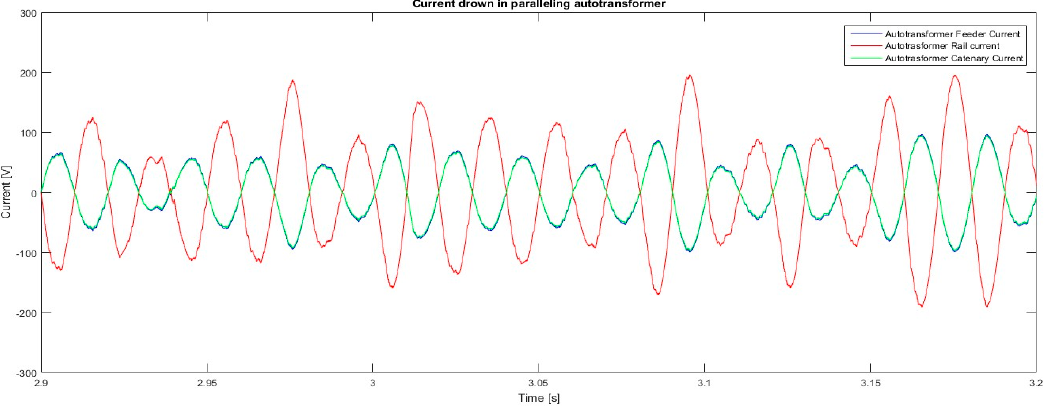
Figure 13. Current measured on the autotransformers connections due to the charging stations.